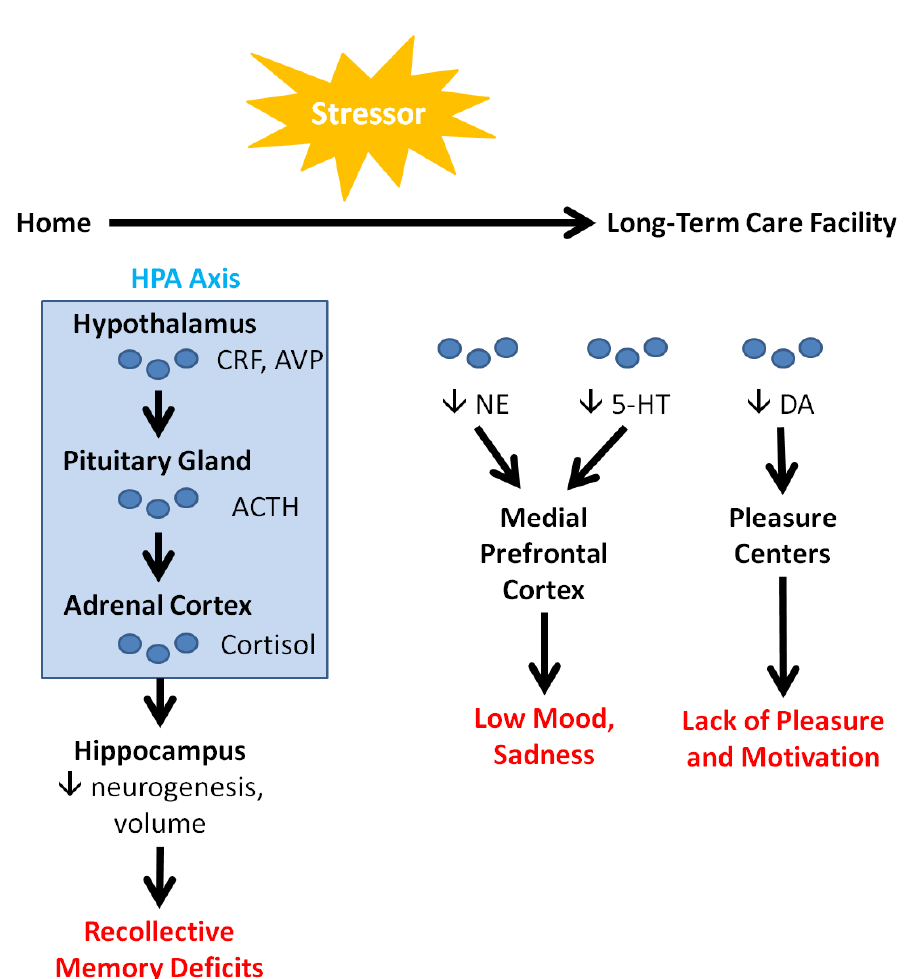
Figure 1. Neurological factors in depression. Acute and chronic stressors, such as disruptions in place attachment bonds, activate the HPA axis and modulate neurotransmitter levels, leading to cognitive and emotional consequences (highlighted in red). These consequences are alleviated in older people by VRT (see Table 1), encouraging the use of VRT with LTCF residents.